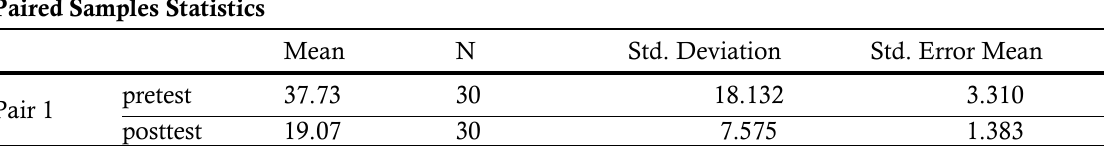
Table 5. Paired sample statistics